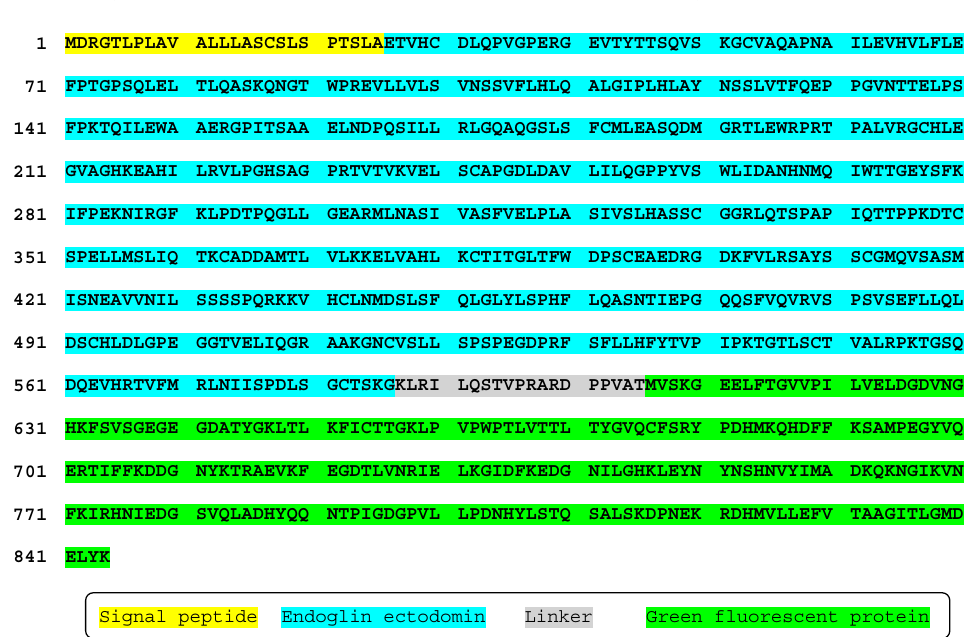
Figure 2. Predicted amino acid sequence of endoglin–GFP fusion protein. Amino acids are numbered on the left. Positions of endoglin signal peptide at N terminus, endoglin extracellular region, a linker sequence, and the green fluorescent protein (GFP) at the C terminus are indicated. A single-letter code for amino acids is used.